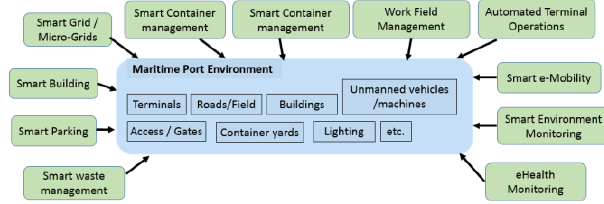
Figure 1 . Extended Smart domains to make from the maritime port a “smart” environment.